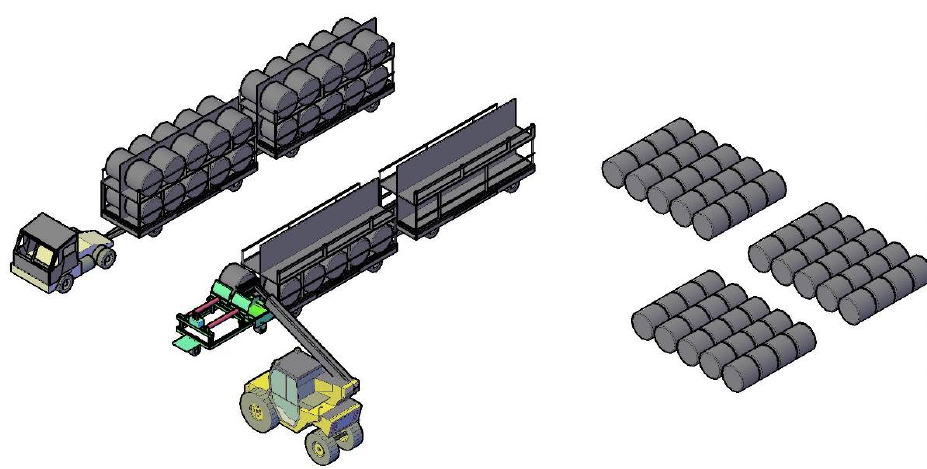
Figure 4. Concept for bale loading at SSL showing an empty rack trailer being filled and a loaded trailer leaving for transport to biorefinery.